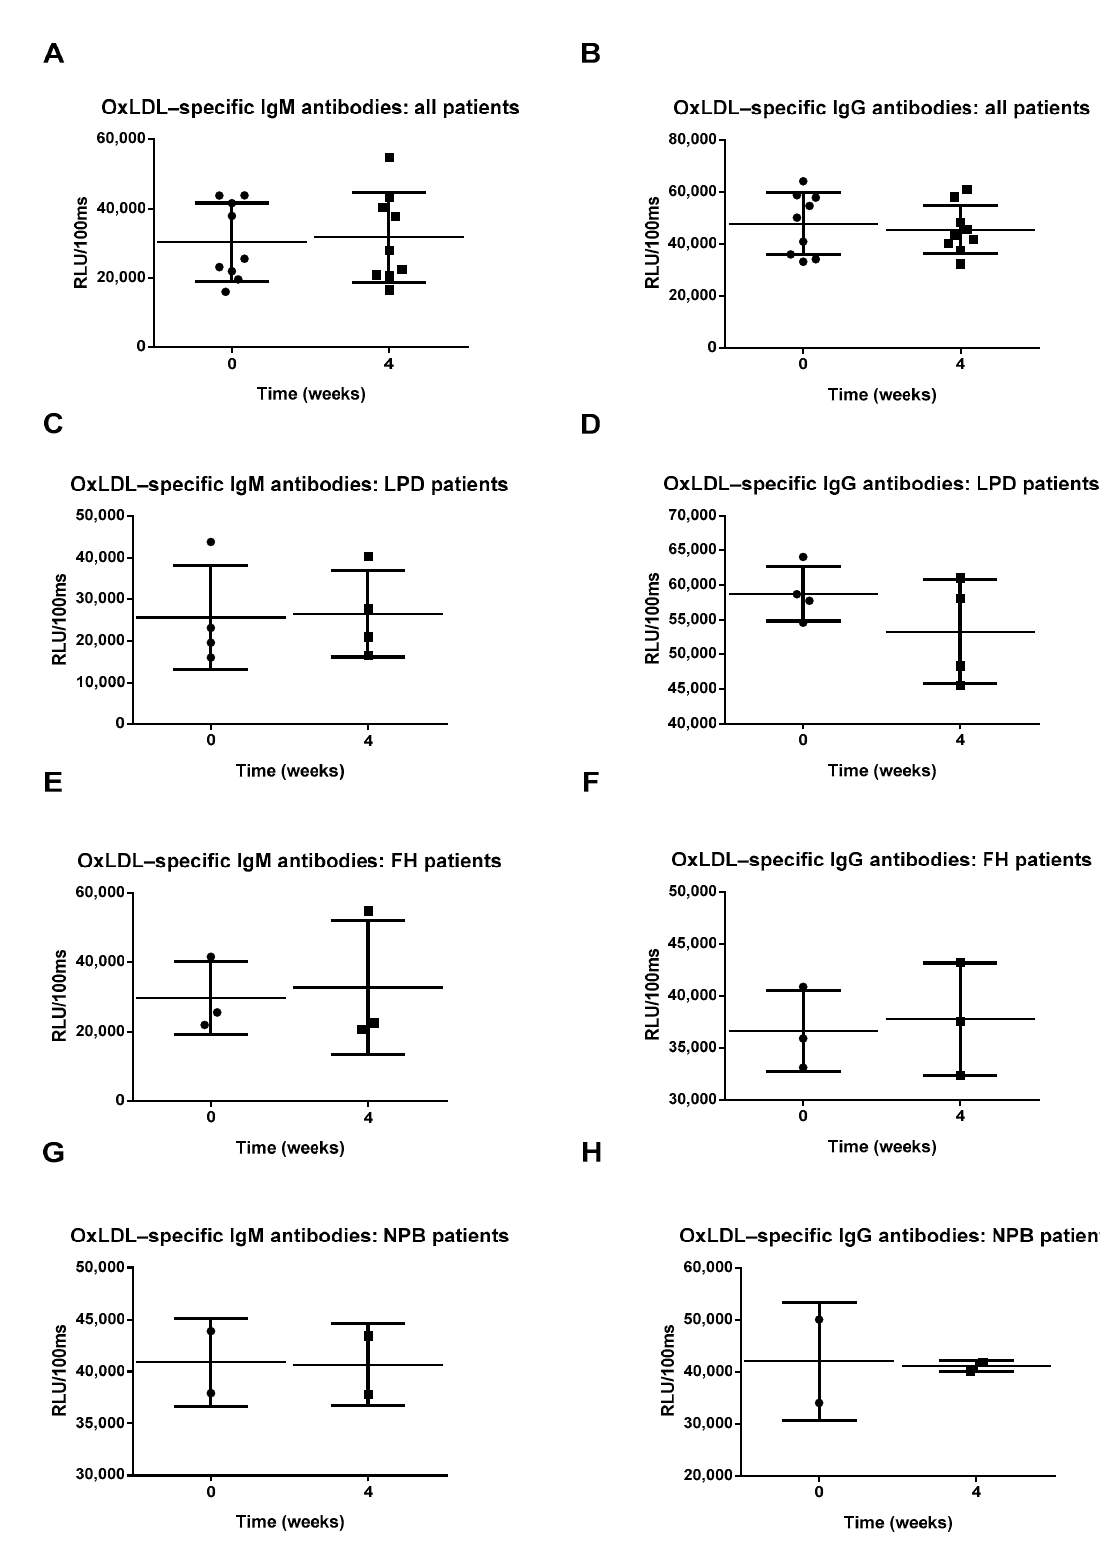
Figure 3. Oxidized low-density lipoprotein (OxLDL)-specific antibody titers ( A – H ). All error bars represent